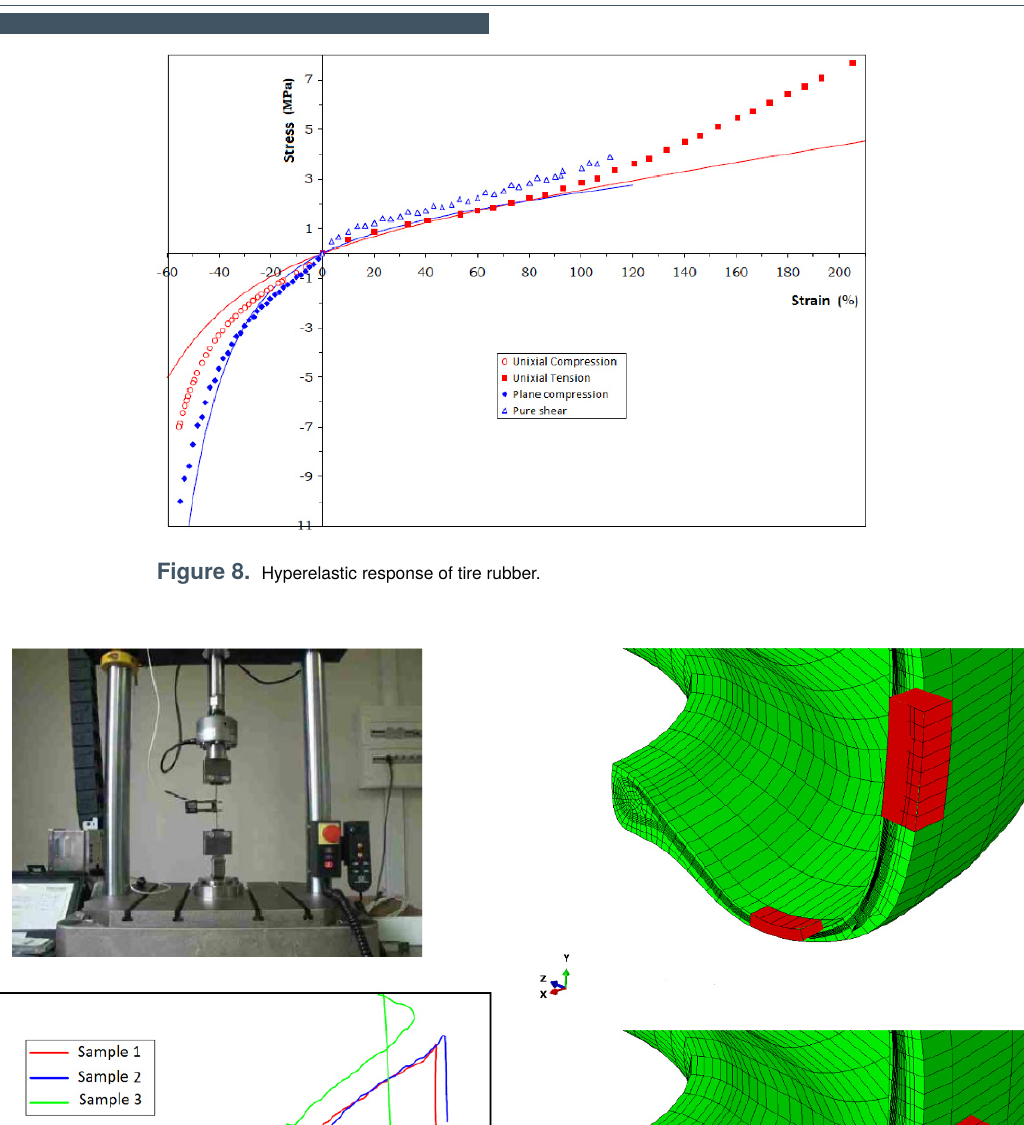
Three specimens of each rubber component were selected and stretched, and data of rubber elongation value for every individual rubber component was obtained by aver- aging the values from the tests on three specimens of each component, while simple tension tests were carried out on